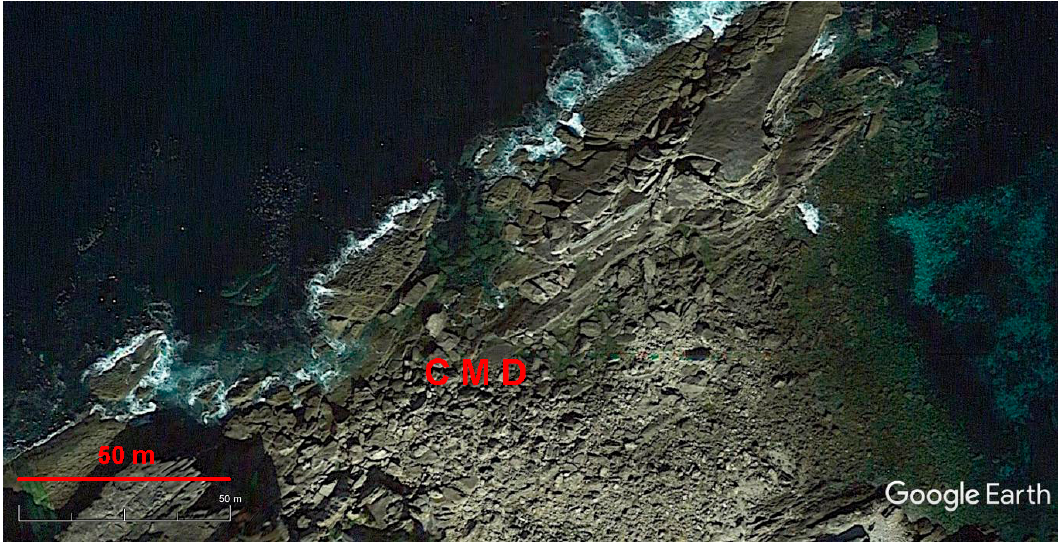
Figure 2. The eastern plot of the Hondarribia locality (the view provided by the Google Earth Engine). CMD labels coastal megaclast deposits (the same is on the following figures).